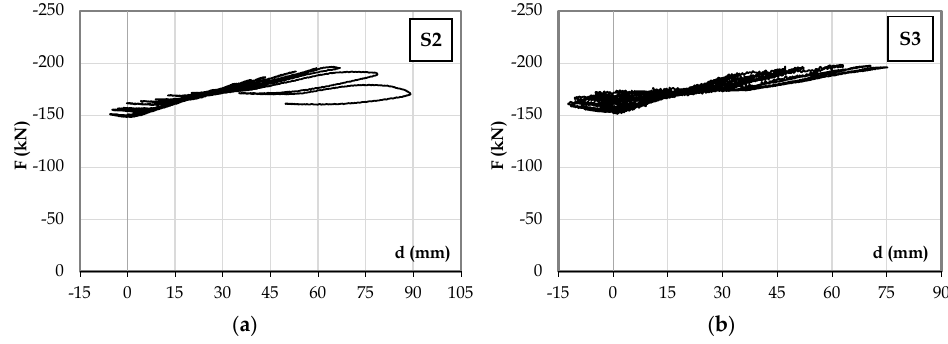
Figure 10. Specimen S3: ( a ) displacement history; ( b ) force-displacement hysteretic diagram. ing losses due to beam degradation near failure.